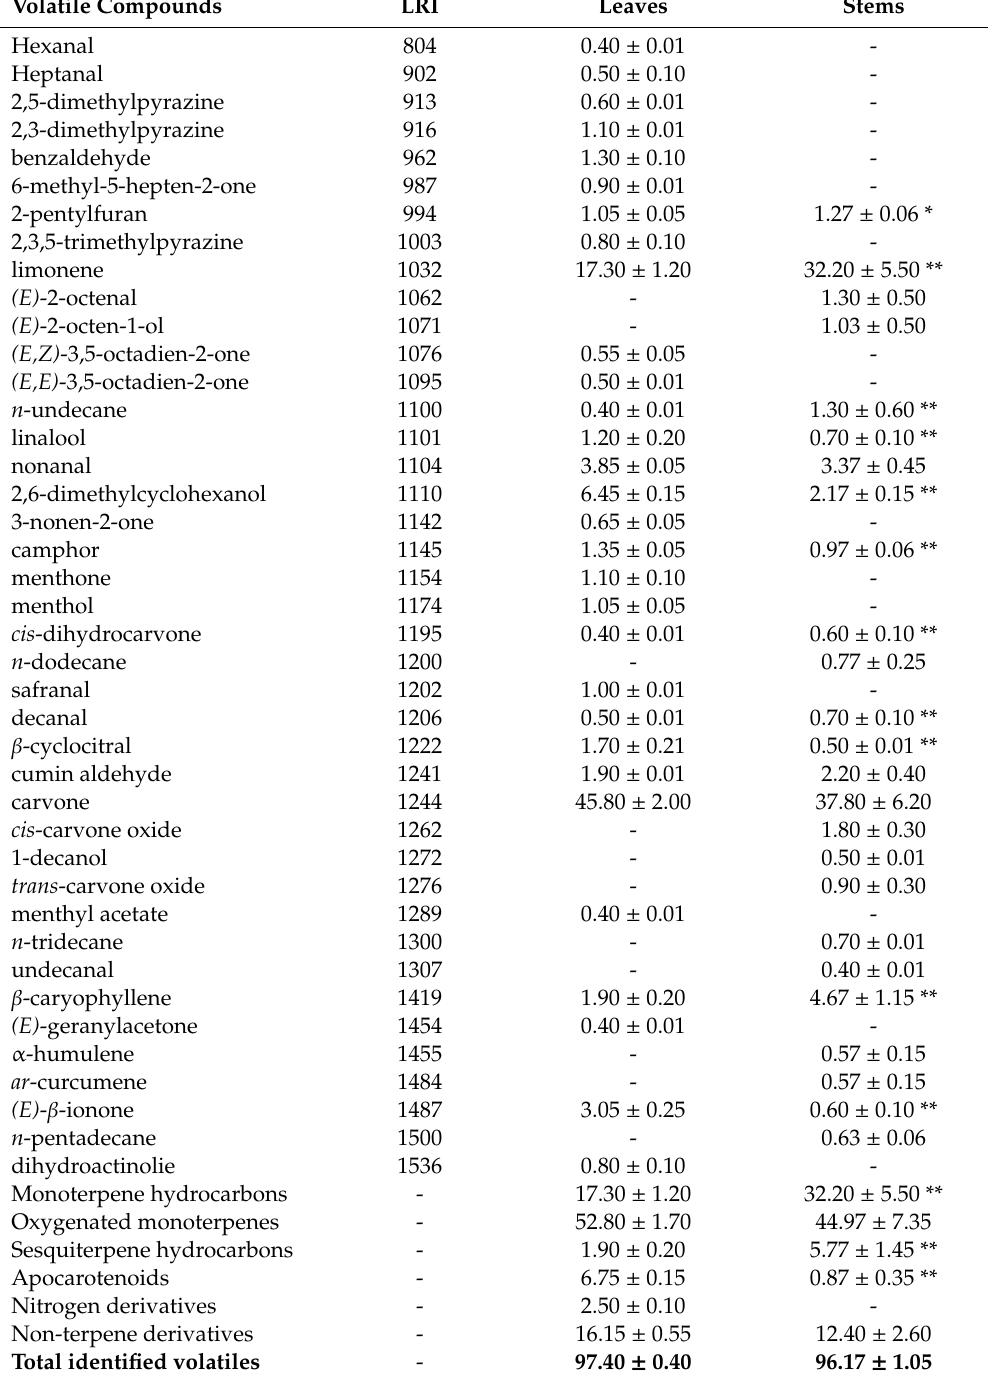
Table 3. Volatile compounds (% DM) from leaves and stems of P. oleracea grown in Tunisia. Volatile